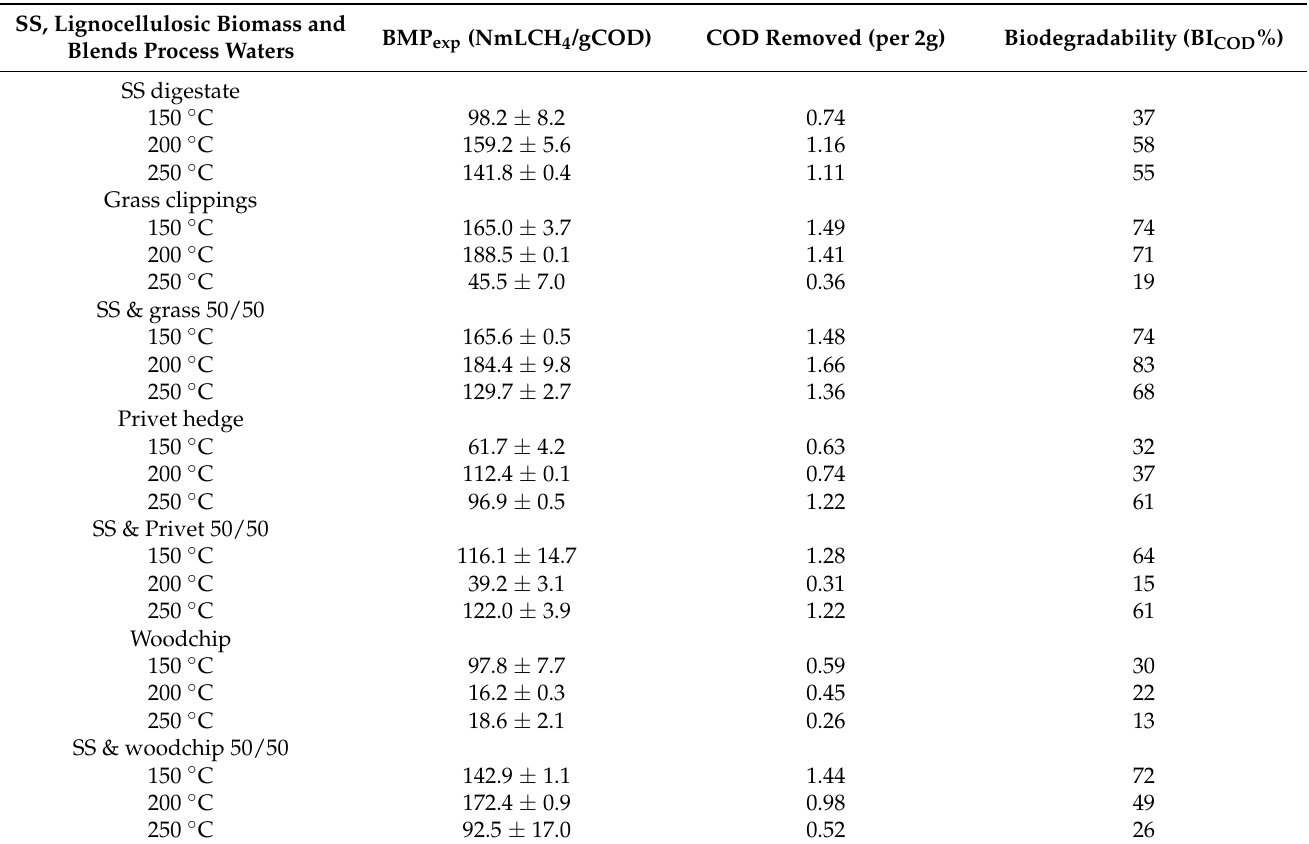
Table 8. Experimental biochemical methane potential (BMP exp ) and biodegradability of process waters from SS digestate, lignocellulosics biomass, and 50/50